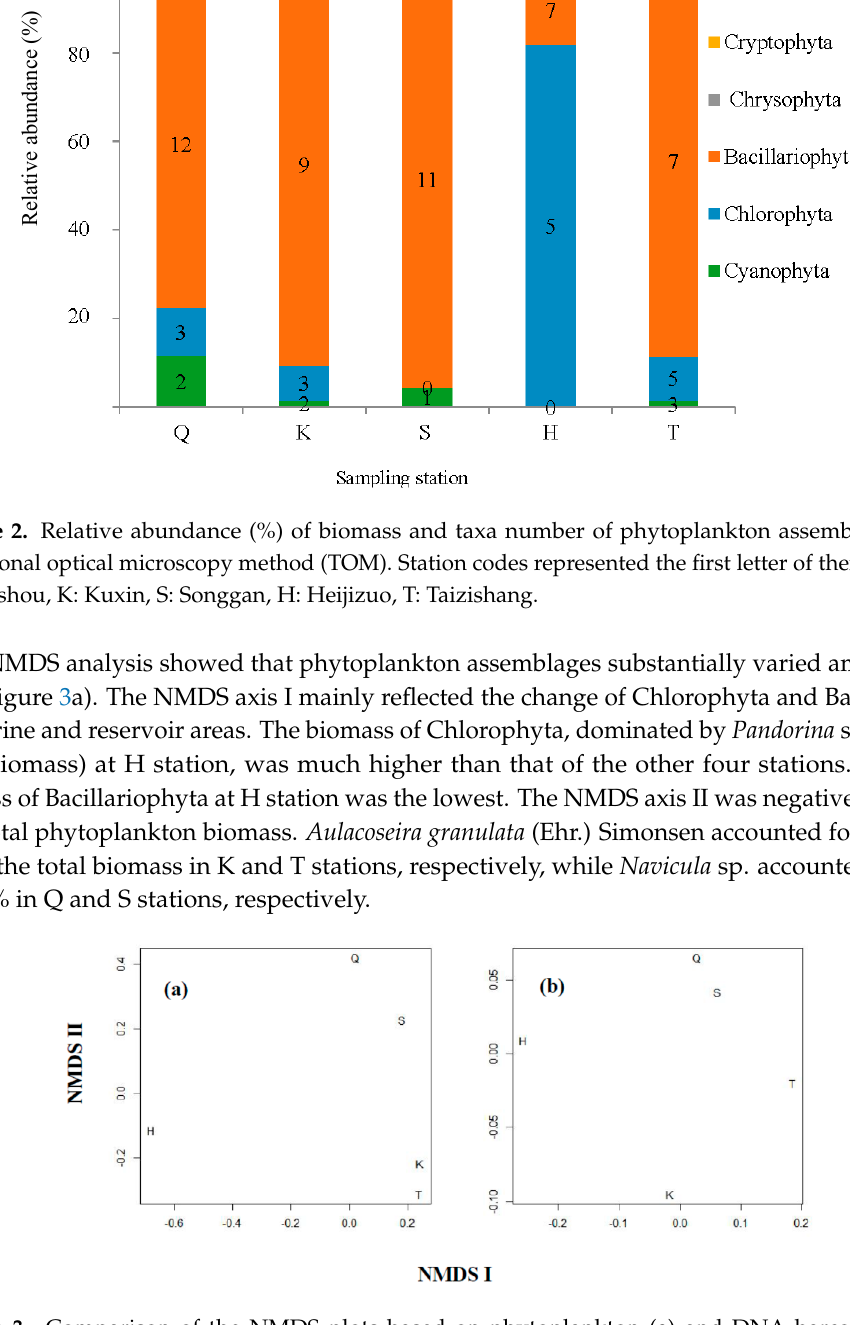
Figure 3. Comparison of the NMDS plots based on phytoplankton ( a ) and DNA barcoding ( b ). Station codes represented the first letter of their names: Q: Qushou, K: Kuxin, S: Songgan, H: Heijizuo, T: Taizishang.